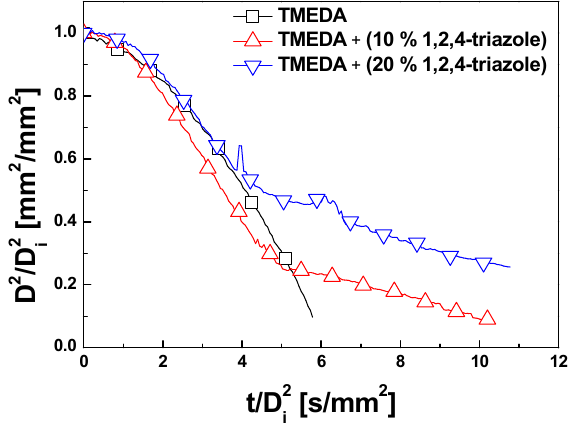
Figure 8. Normalized variation of evaporating TMEDA-based fuel droplet diameter squared with normalized time at 200 °C.